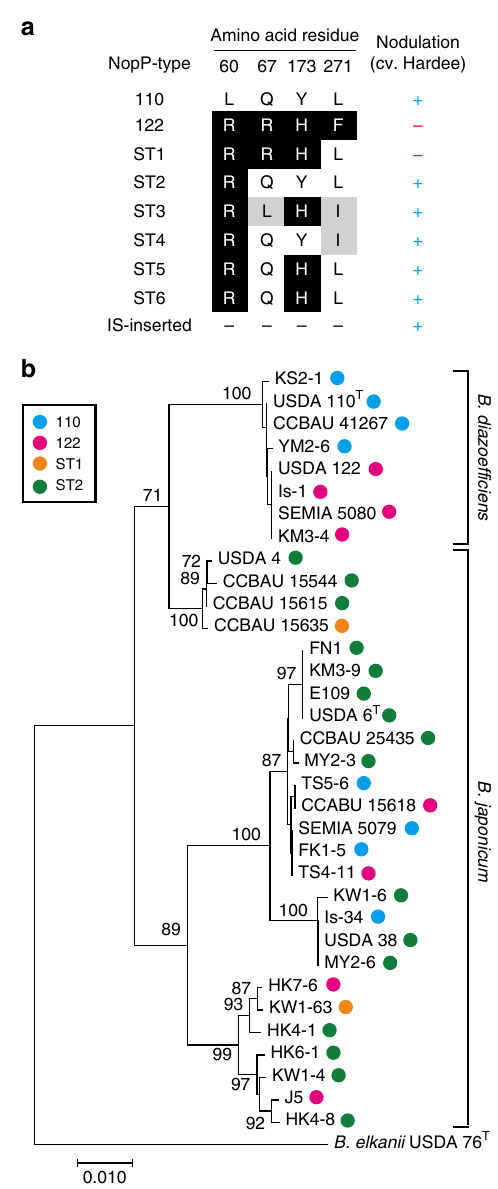
Fig. 8 Diversity of NopP among soybean bradyrhizobia. a Differences in deduced NopP amino acid sequences among B. diazoef fi ciens and B. japonicum strains. Amino acid residues in NopP at positions 60, 67, 173, and 271 in each type and nodulation phenotype of a representative strain(s) on G. max cv. Hardee (Supplementary Fig. 11) are shown. b Phylogenetic tree of B. diazoef fi ciens and B. japonicum based on 16S – 23 S rRNA internal transcribed spacer (ITS) sequences. Numbers at the nodes are the percentages of 1000 bootstrap replications supporting that partition (values ≥ 70% are shown). NopP types (indicated by colored circles) were assigned on the basis of the patterns of amino acid sequences deduced from genomic sequences (Supplementary Table 3). The scale bar shows the number of base substitutions per